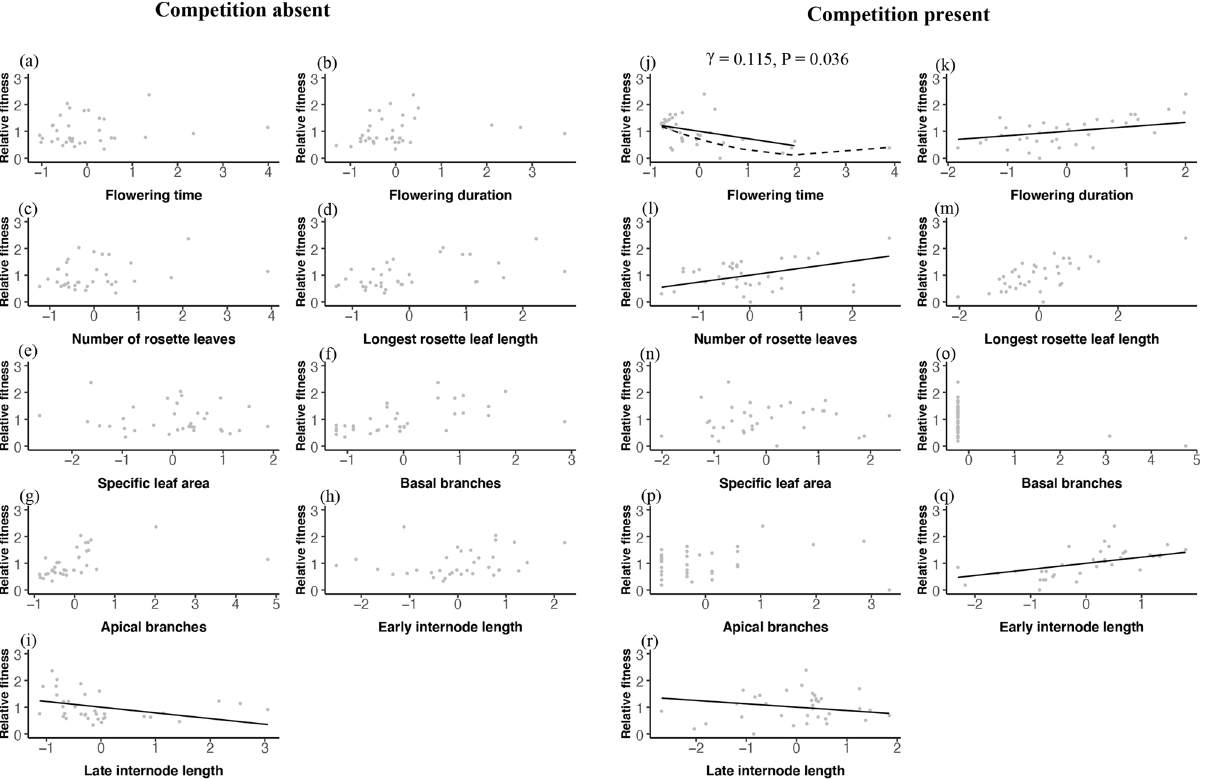
Figure 2. Relationships between relative fitness (fruit number) and standardized trait values from phenotypic selection models in competition-absent ( a – i ) and competition-present ( j – r ) conditions. Solid lines represent significant selection gradients ( β ), based on model parameter estimates in Table 1. Dashed lines represent significant nonlinear relationships, based on parameter estimates from the quadratic phenotypic selection model (γ and P values shown for all cases with P <